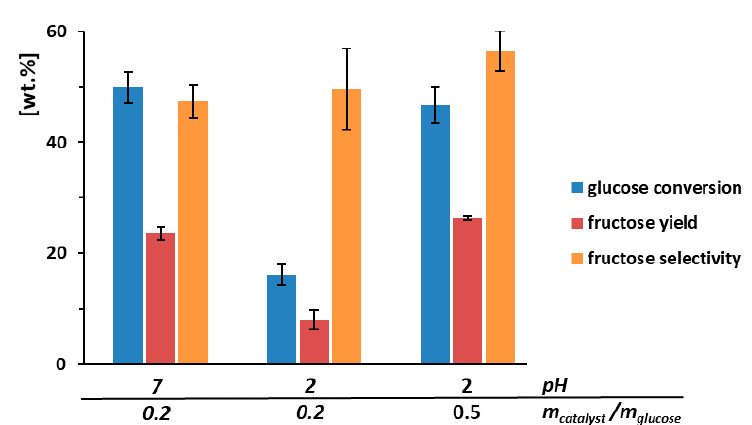
Figure 6. Glucose conversions and fructose yields with calcinated hydrotalcite with variation of the pH value by adding sulfuric acid, constant parameters c glucose = 5 g/L, air atmosphere, T = 100 °C, t = 40 min.